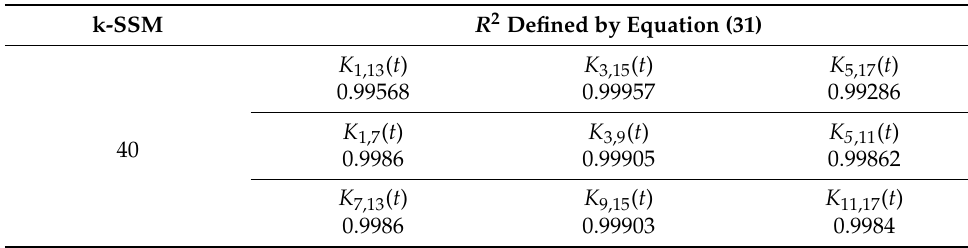
Table 4. R 2 values for SSMs identified based on the frequency-domain results for the coupling term between different